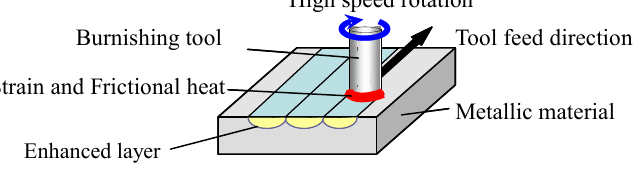
Figure 1. Scheme of the friction stir burnishing.